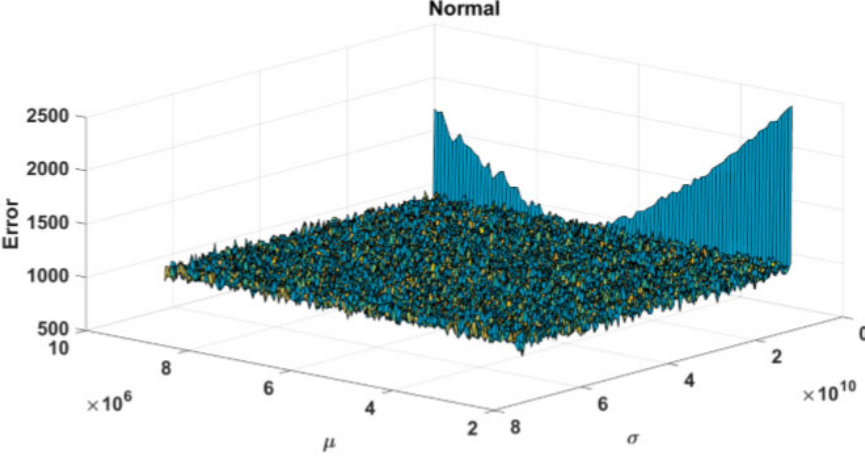
Figure 5. Validation error (Normal).